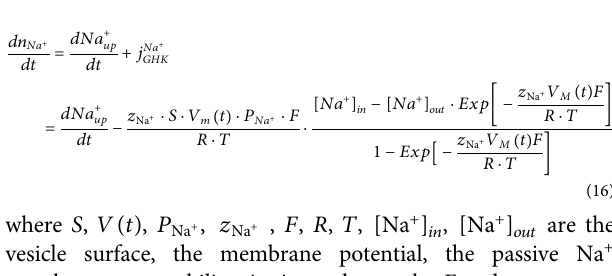
Frontiers in Physiology |